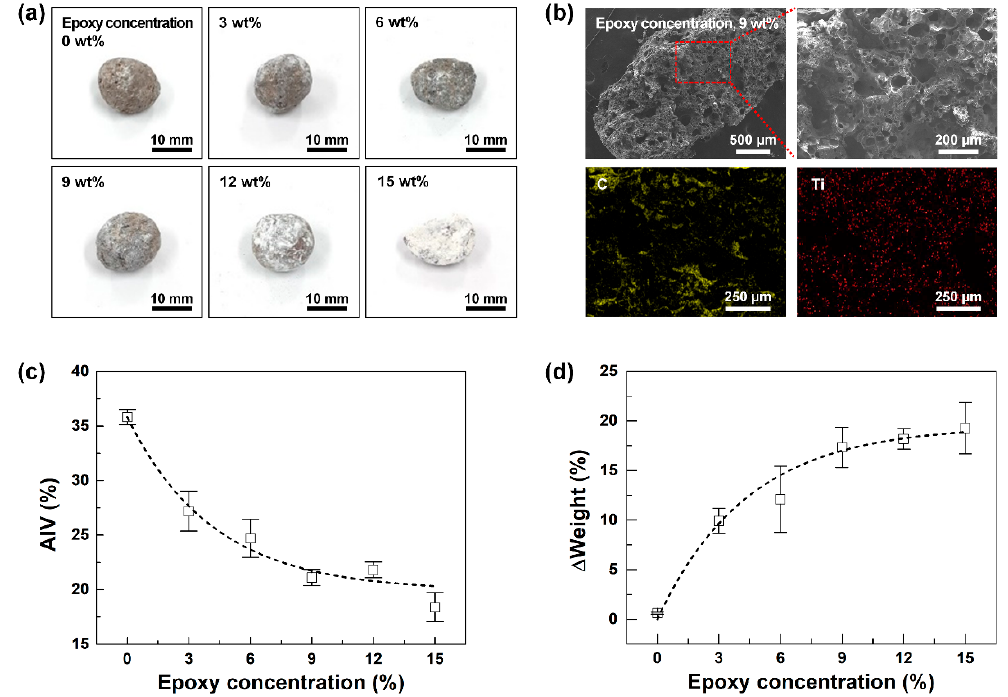
Figure 3. Optimization of LWA properties according to the concentration of epoxy–TiO 2 composite solution. ( a ) Photo image of the epoxy–TiO 2 -embedded high-strength functional LWA according to six epoxy concentration conditions (0, 3, 6, 9, 12, and 15 wt.%). ( b ) FE–SEM image and EDS elemental image of C and Ti of 9 wt.% epoxy–TiO 2 -embedded high-strength functional LWA. ( c ) Aggregate impact value (AIV). ( d ) Weight changes of the epoxy–TiO 2 -embedded high-strength functional LWA according to the change in epoxy coating concentrations.